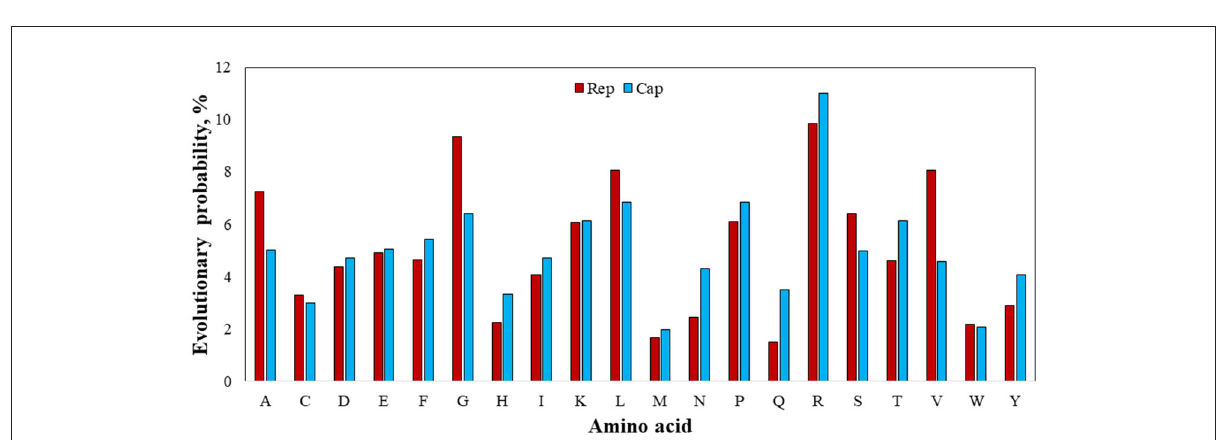
FIGURE8 Evolutionary probability of involved amino acids within rep and cap sequences, including GenBank sequences and rep and cap sequences. Mega ver. 11 was used for this analysis based on Jones-Taylor-Thornton (JTT) model and Bayesian/Realtime statistical method.